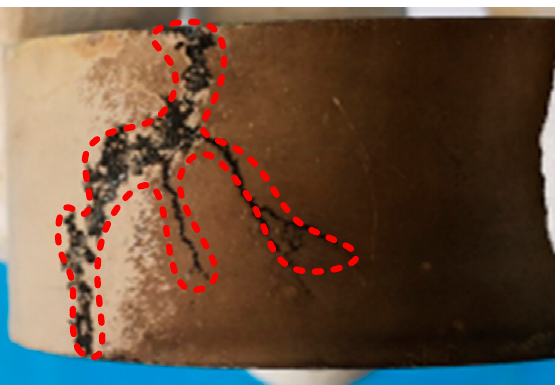
Figure 13. Defect valve plates.